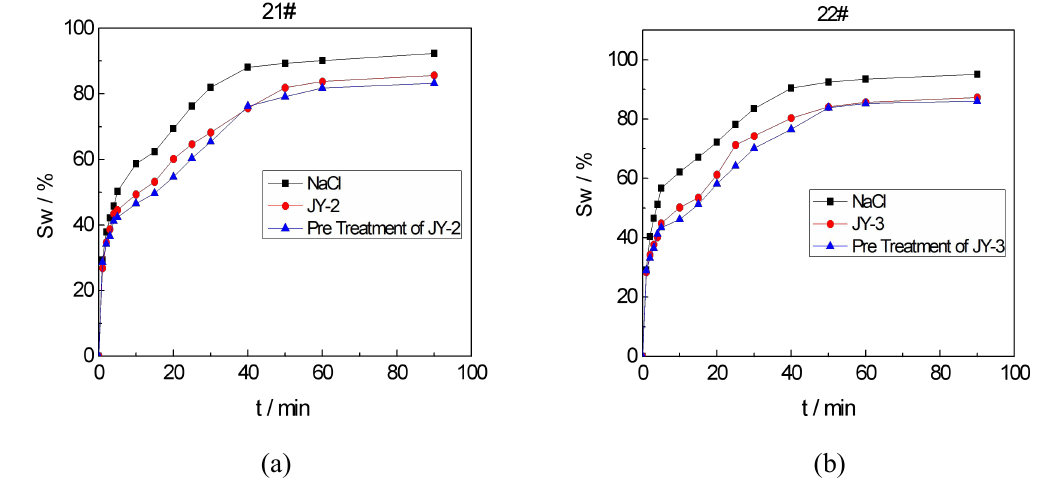
Figure 7—Spontaneous imbibition curves. (a) #21. (b) #22.